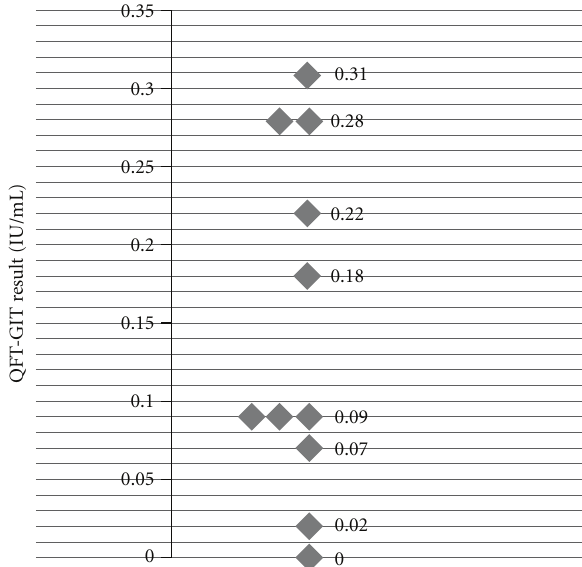
Figure 1: Range of QFT-GIT values below the cuto ff of 0.35IU/mL for patients with active